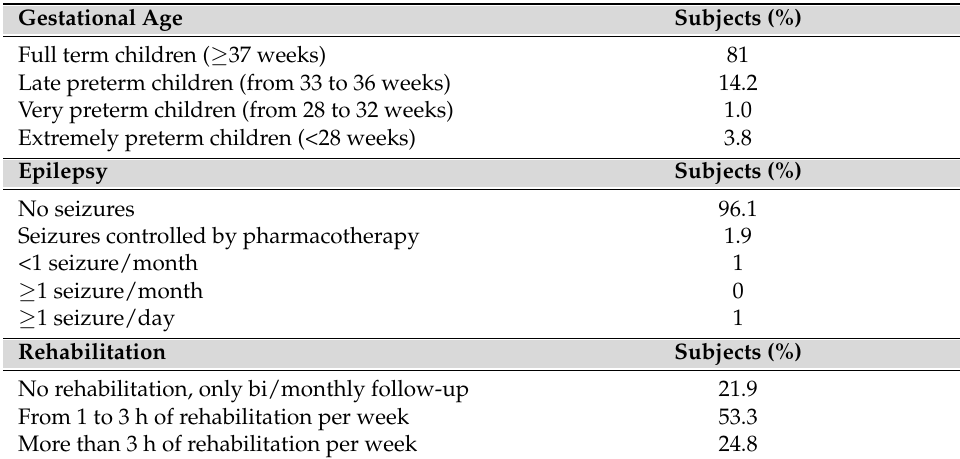
Table 2. Clinical features of the